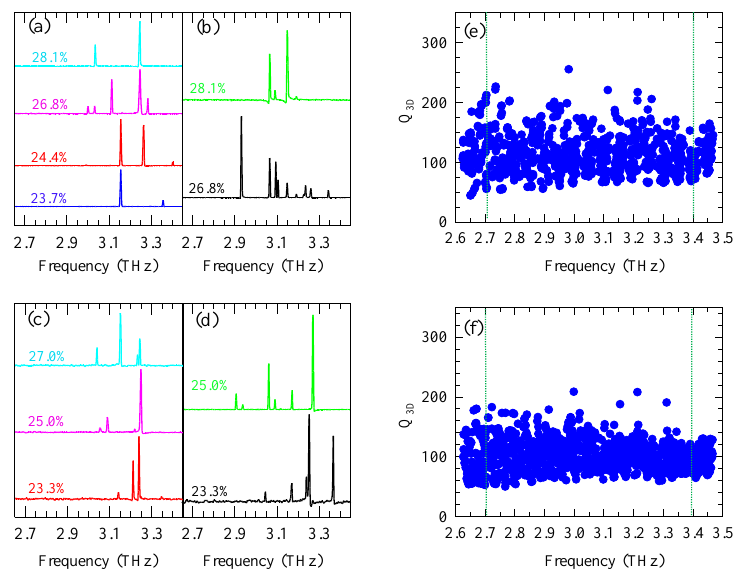
Photonics 2016 , 3 , 32